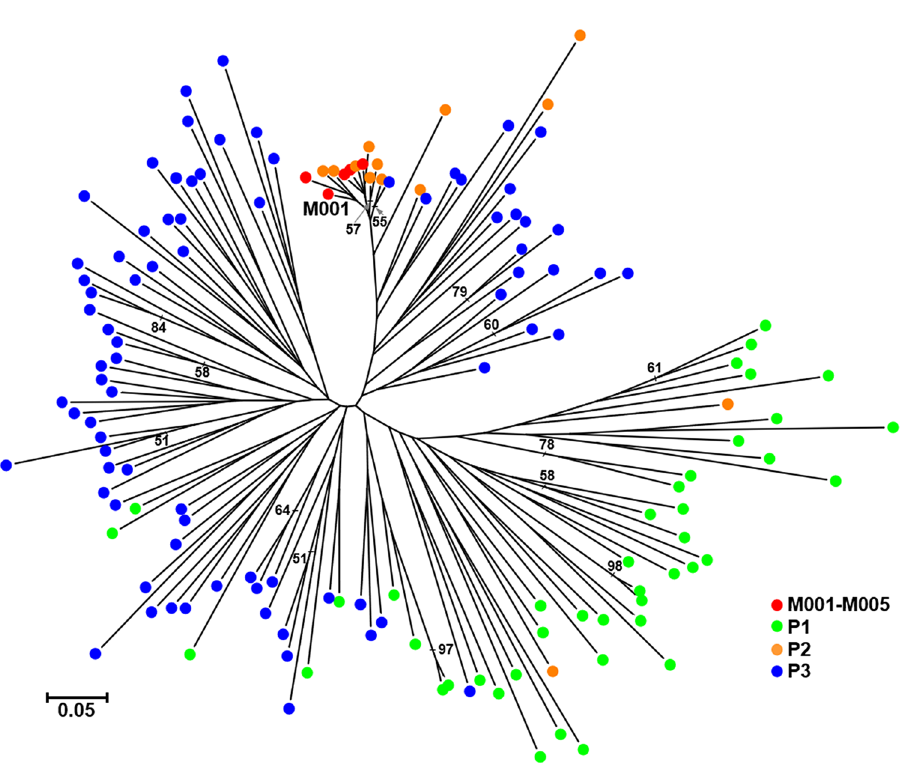
Figure 3. Neighbor-joining tree based on microsatellite marker data of 141 sweet chestnut multi-locus genotypes. The clonal group (M001–M005) or the population of origin (P1, P2, P3) of each MLG are indicated on branches of the tree. The numbers above branches indicate bootstrap support values over 50% in 1000 pseudoreplicates. The tree was visualized using MEGA7 (https:// www. megas oftwa re.